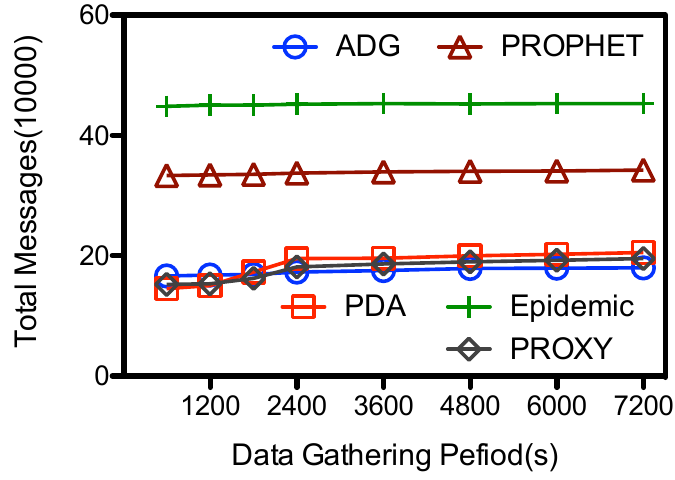
Figure 9. Data gathering duration ( Υ ) vs. total message transmissions.